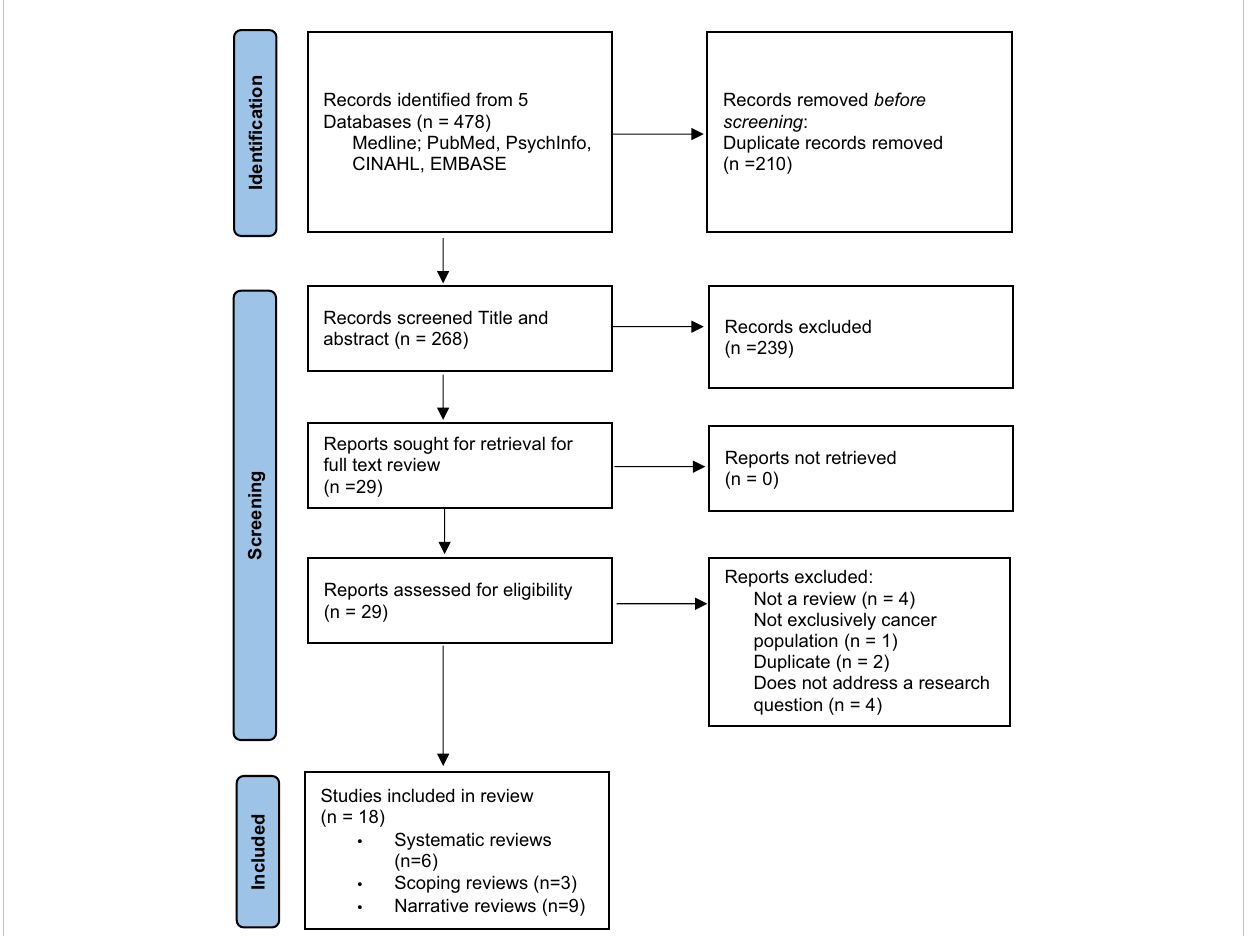
FIGURE 1 Preferred Reporting Items for Systematic Reviews and Meta-Analyses (PRISMA) fl ow